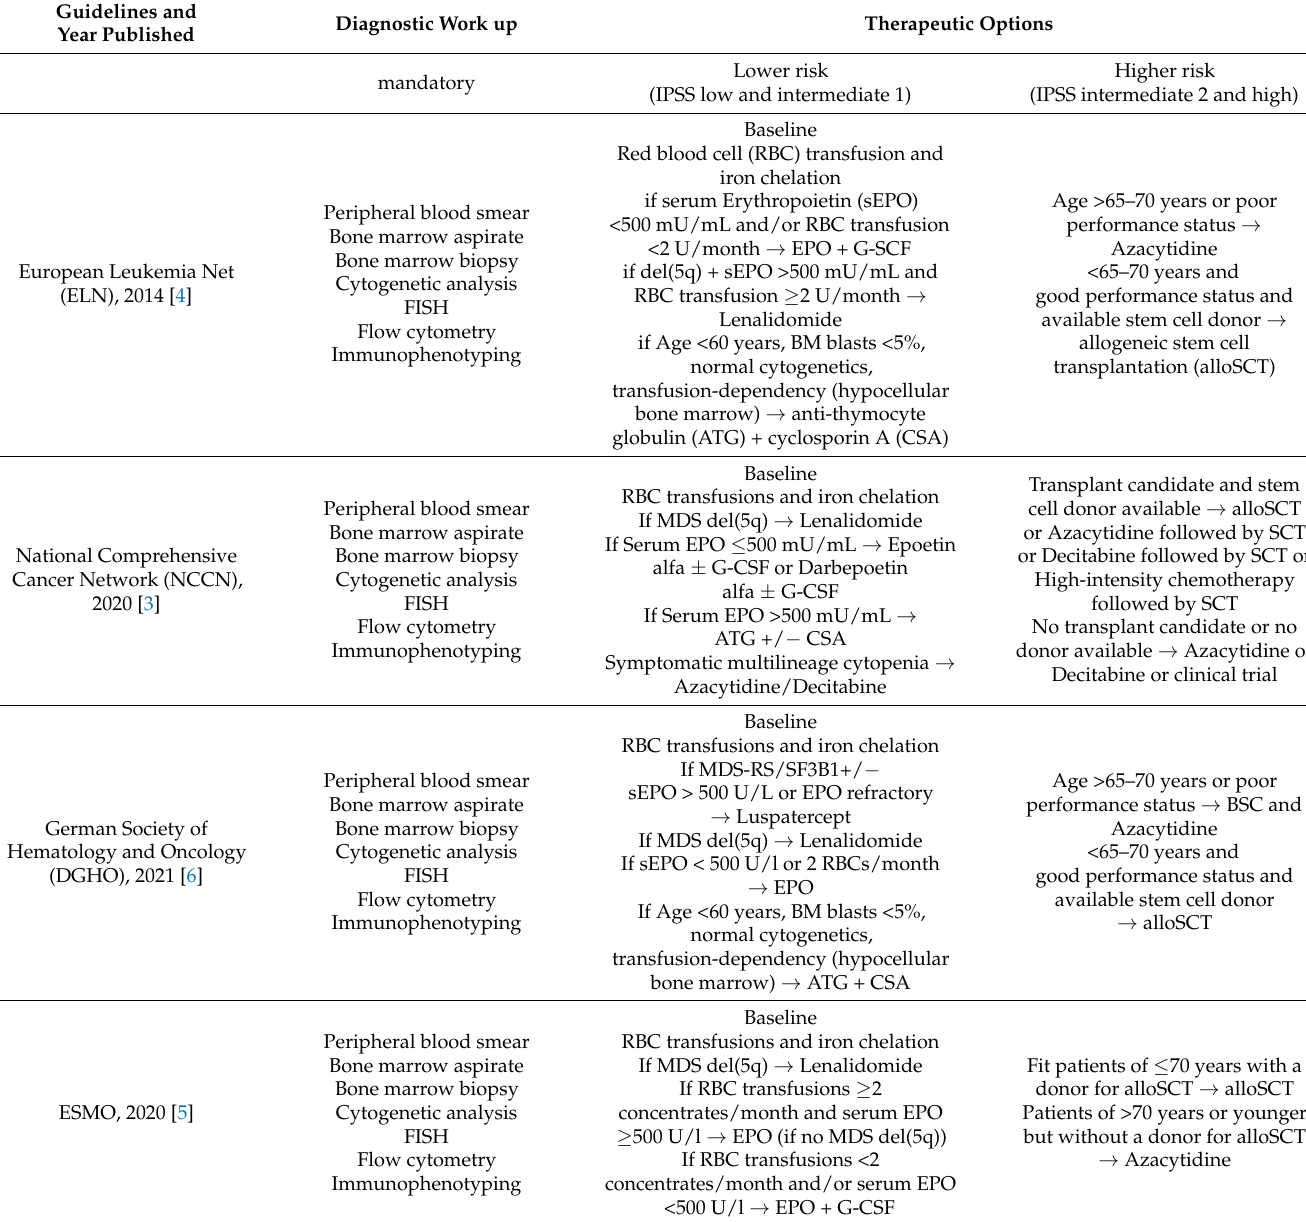
Table 1. Overview of national and international MDS practice guideline